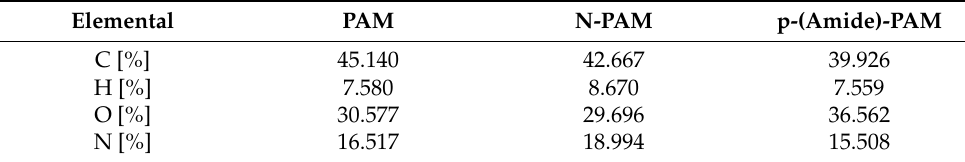
Table 1. The elemental content of PAM, N-PAM, and p-(Amide)-PAM.